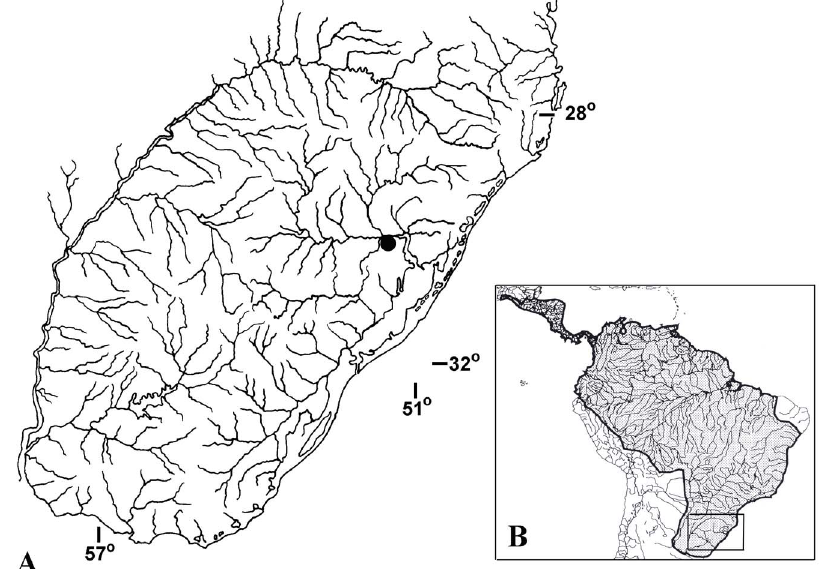
Figure 1. Sampling site of Brachyhypopomusgauderio . Geographic location of the sampling site of Brachyhypopomus gauderio . A: sampling site of B . gauderio in the Rio Grande do Sul State, Brasil; B: distribution of the order Gymnotiformes through the Neotropical region.